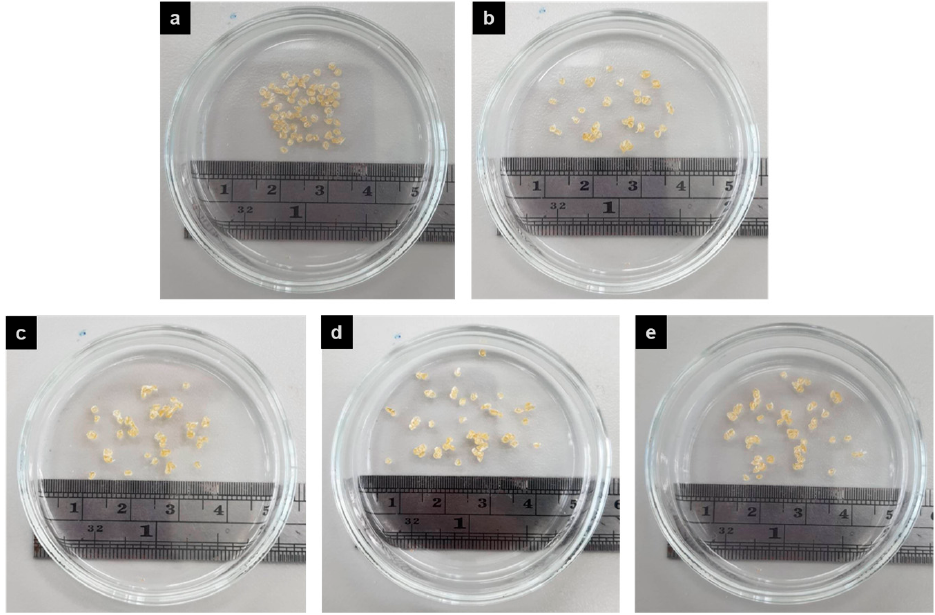
Figure 11. Physical appearance of ( a ) CS beads; ( b ) M0.50/P30-DPNR-coated CS beads; ( c ) M0.50/P30-DPNR/Si10-coated CS beads; ( d ) M0.50/P30-DPNR/Si20-coated CS beads and ( e ) M0.50/P30-DPNR/Si30-coated CS beads.